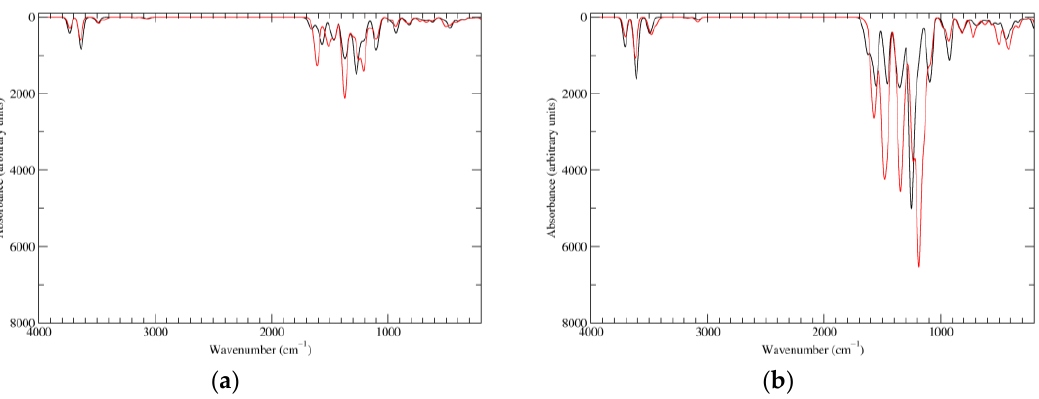
Figure 6. Computed IR spectra of the most significant tautomers/conformers in the two-electrons oxidation state. ( a ) Neutral form in vacuo: black line, a16_b0_c0_d0, C 1 , conf1; red line, a6_b6_c0_d0, C 1 , conf1. ( b ) Neutral form in water: black line, a16_b0_c0_d0, C 1 , conf1; red line, a6_b6_c0_d0, C 1 , conf1.